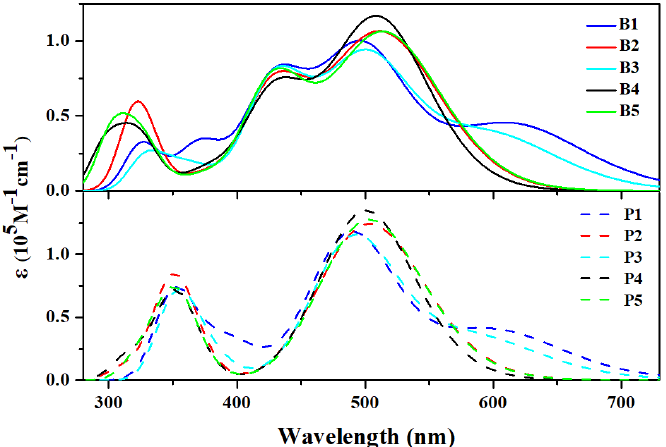
Figure 4. The calculated absorption spectra of all the studied Cu(I) ‐ based dyes.